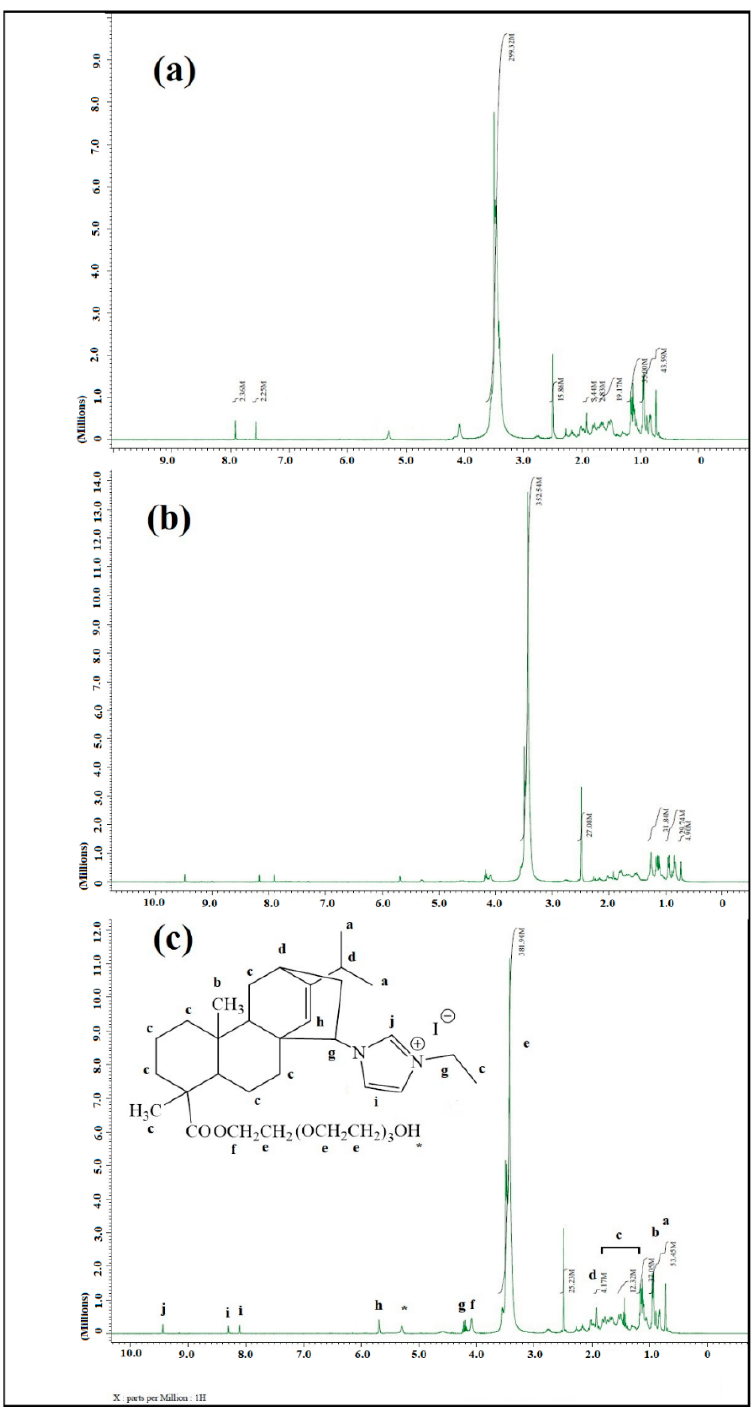
Figure 2. 1 HNMR spectra of ( a ) ATI, ( b ) ATHI-IL, and ( c ) ATEI-IL. Ionic liquid compounds are known for their high thermal stabilities that broaden their applications as green solvents, additives in enhanced oil recovery, etc. [27]. TGA-